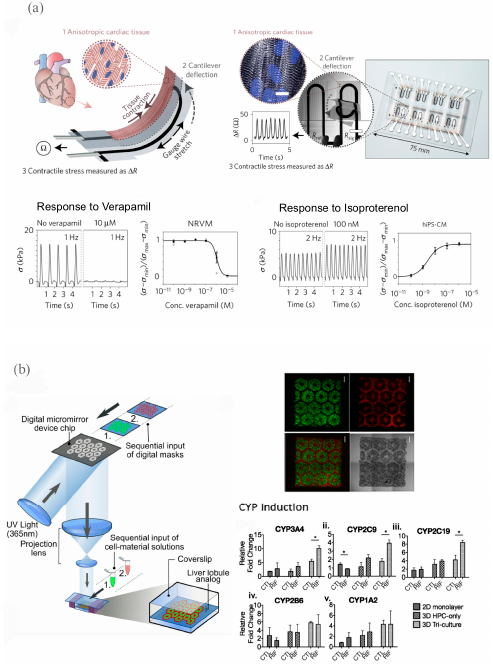
Figure 6. Bioprinted cardiovascular and liver models for drug development. ( a ) Schematic diagram of cardiac tissue model design with stress sensors (scale bars are 10 mm) and verapamil and isopro- terenol dose-response plots below. Adapted with permission from [85]. 2016, Nature Publishing Group. ( b ) DLP-bioprinted hepatic model on left, fluorescence and bright field images of 3D-printed construct on top-right, and CYP induction plots on lower-right with asterisks indicating statistical significance with threshold of p < 0.05 (scale bars are 500 mm). Adapted with permission from [86]. 2015, S. Chen.